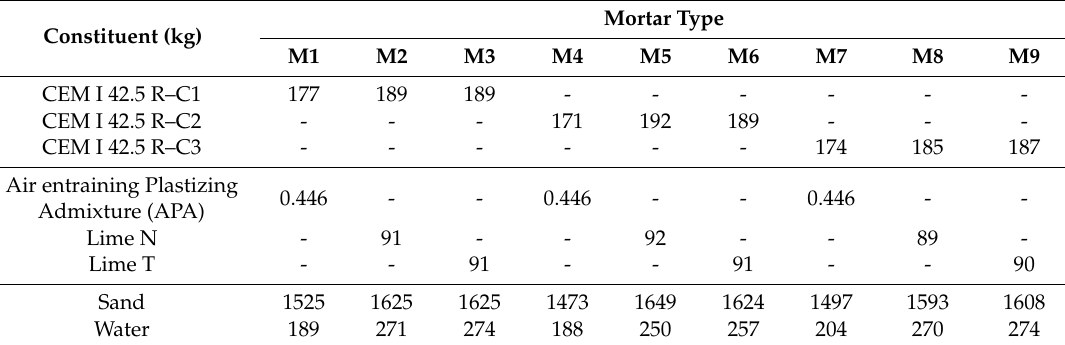
Table 4. The initial composition of masonry mortars (kg / m 3